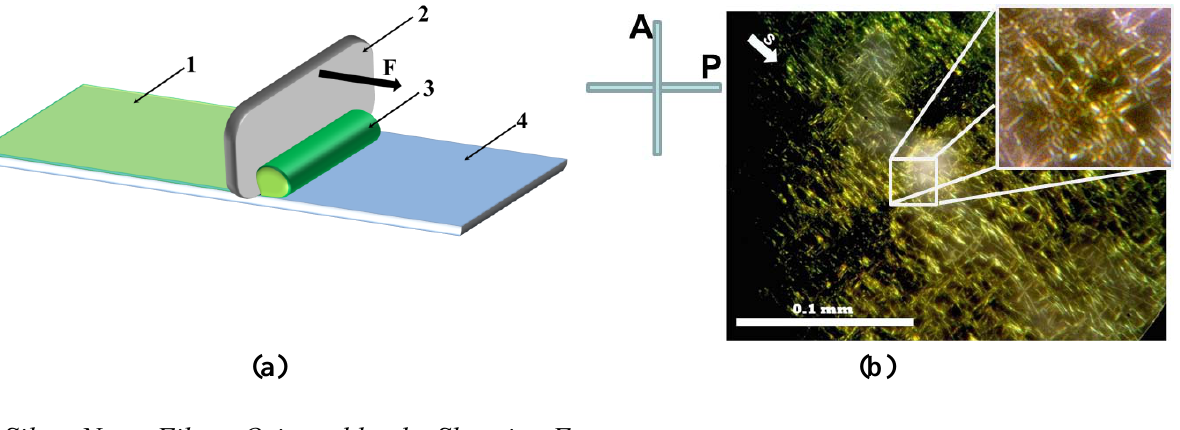
Figure 1. (Color online) ( a ) Shearing setup with the layer of silver nano-fibers (1), doctor blade (2) with applied force F, droplet of the colloidal dispersion (3), and bare borosilicate glass plate (4); ( b ) The microspore texture of Sample No. 1 with dried silver nano-fibers NGAP NF Ag-3101-W, which was captured between crossed polarizer (P) and analyzer (A). Vector S depicts the direction of